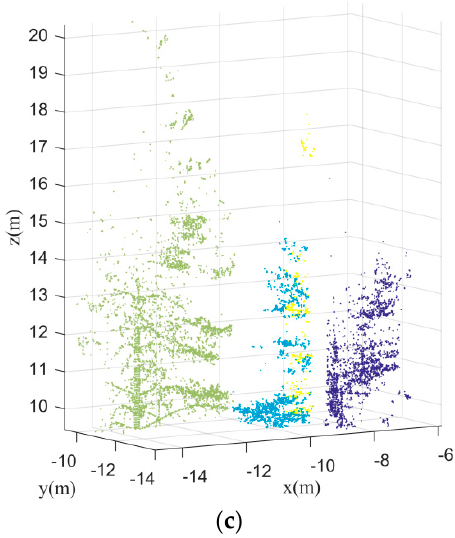
Figure 20. Separation results towards different separation number by applying the Gaussian mixture model separation. ( a ) The separation number is 2; ( b ) the separation number is 3; ( c ) the separation number is 4.